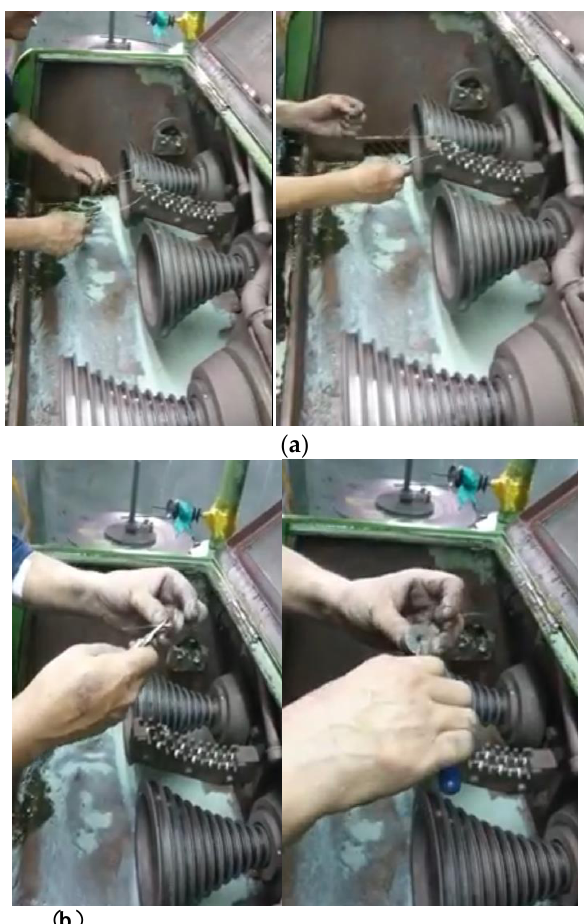
Figure 1. Human operation for wire dies mold treading. ( a ) Wire elongating process by hands; ( b ) wire treading dies mold.